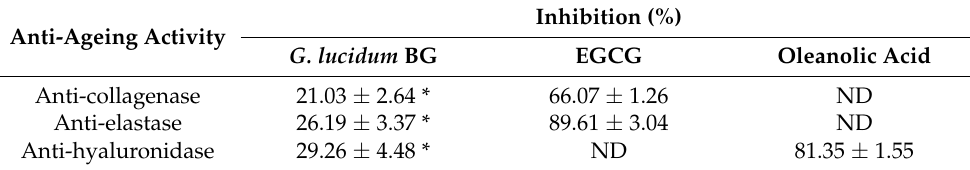
Table 4. Anti-ageing activity of antler-type G. lucidum BG.